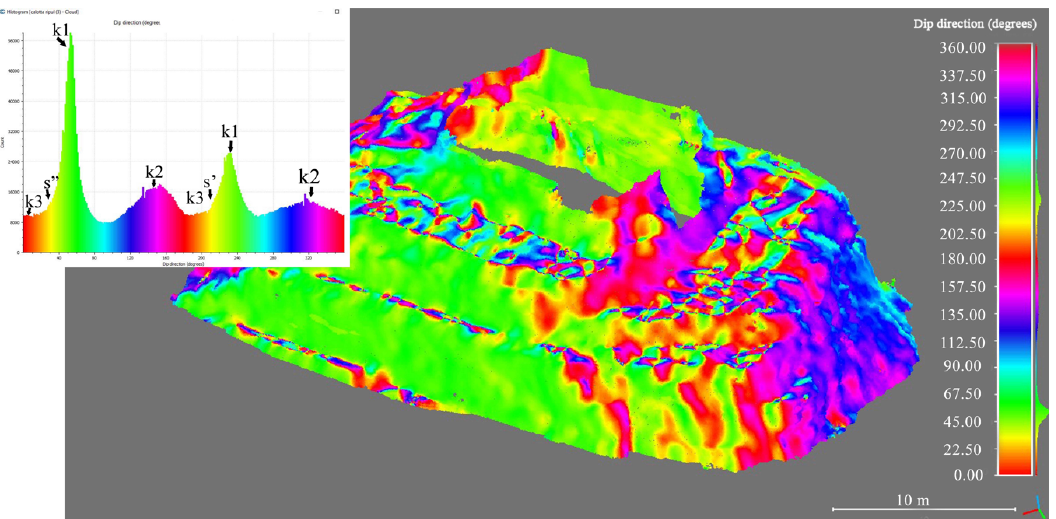
Figure 13. Mapping the dip direction value attributed to the point cloud of the Grave at Castellana Caves. In the inset, the histogram shows distribution of the discontinuity sets, with the most represented clearly corresponding to peaks.